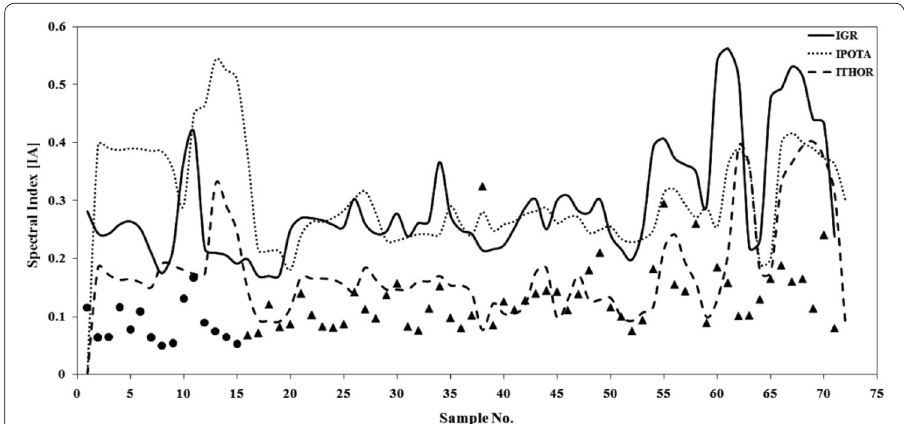
Fig. 5 The comparison between unmodified ray indexes and core-measured clay contents. Black circle Gas producing well data points, black up-pointing triangle non-producing well data